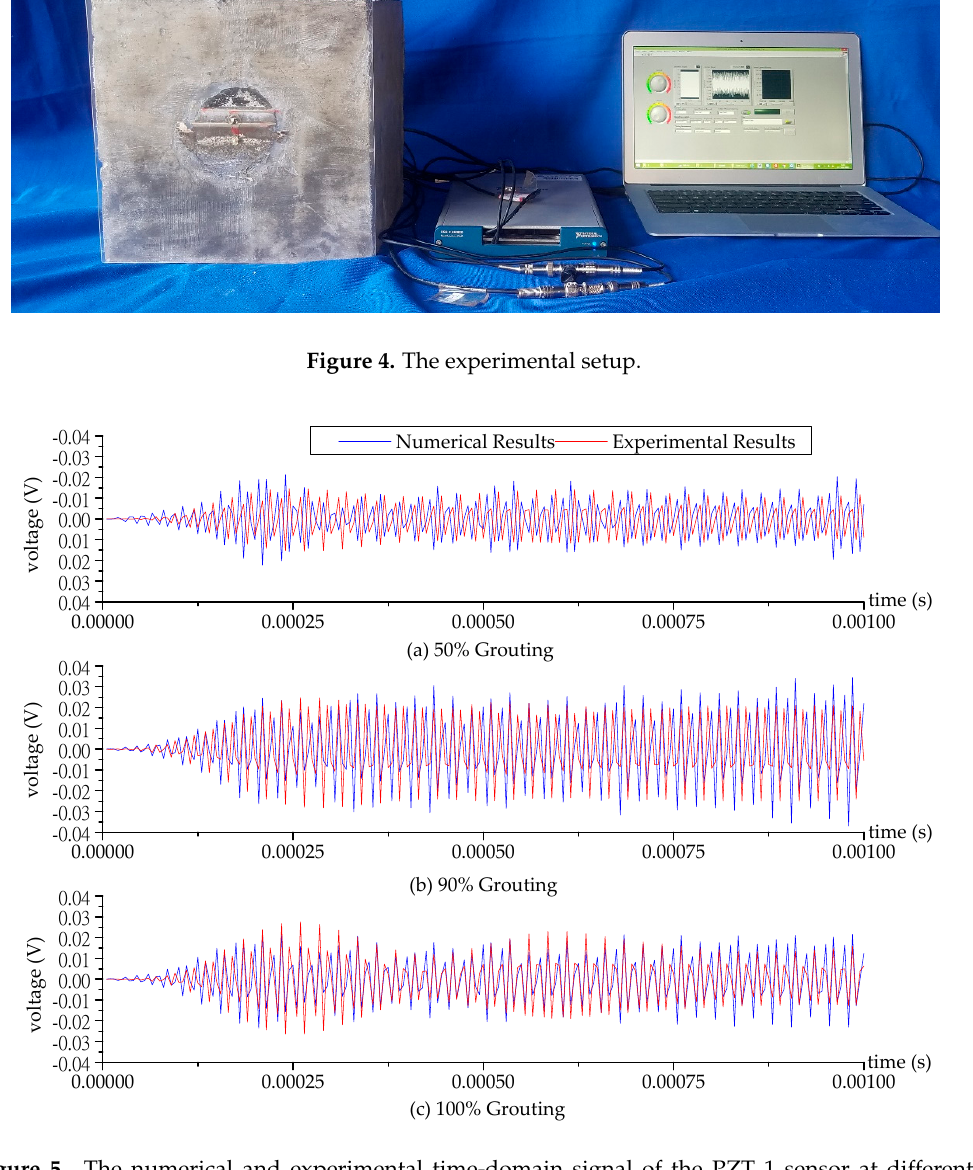
Figure 5. The numerical and experimental time-domain signal of the PZT 1 sensor at different grouting levels.